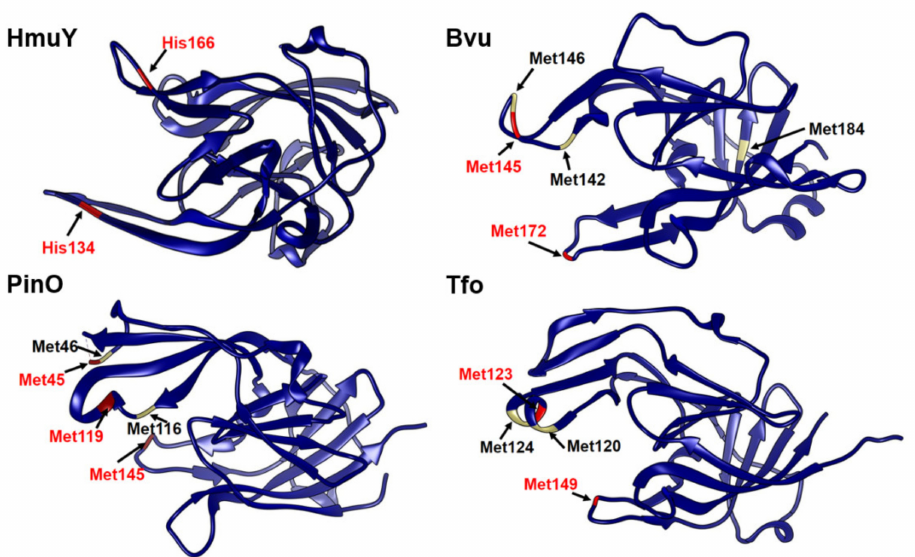
Figure 3. Three-dimensional protein structures of HmuY and its homologs. Apo-protein structures of P. gingivalis HmuY (PDB ID: 6EWM), P. intermedia PinO (PDB ID: 6R2H), T. forsythia Tfo (PDB ID: 6EU8), and B. vulgatus Bvu (PDB ID: 3U22) are shown. Experimentally confirmed amino acids coordinating heme iron are shown in red. Other putative amino acids potentially involved in heme iron binding in HmuY homologs, examined by site-directed mutagenesis, are shown in black. Protein structures were visualized using the program Chimera